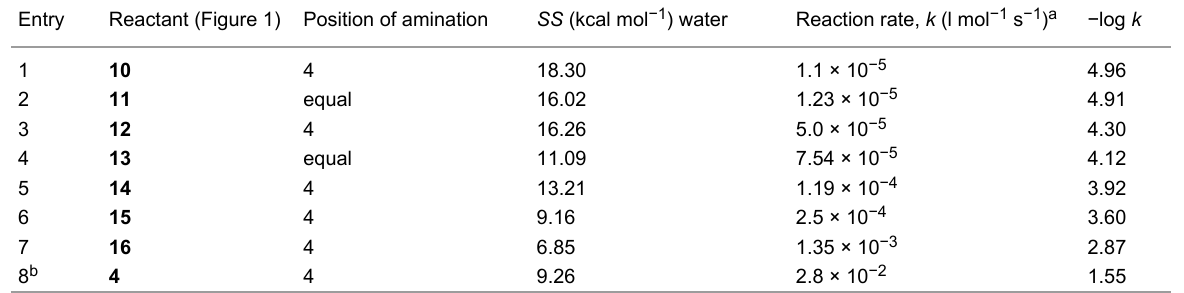
Table 2: Series B. Sigma stability ( SS ), experimental rate constants [22,28] and negative logarithms for experimental rate constants ( − log k ) for the amination (with NH 3 ) of different reactants in dioxane/water (60:40 v/v) at 80 °C. The structures of the reactants are shown in Figure 1. Entry